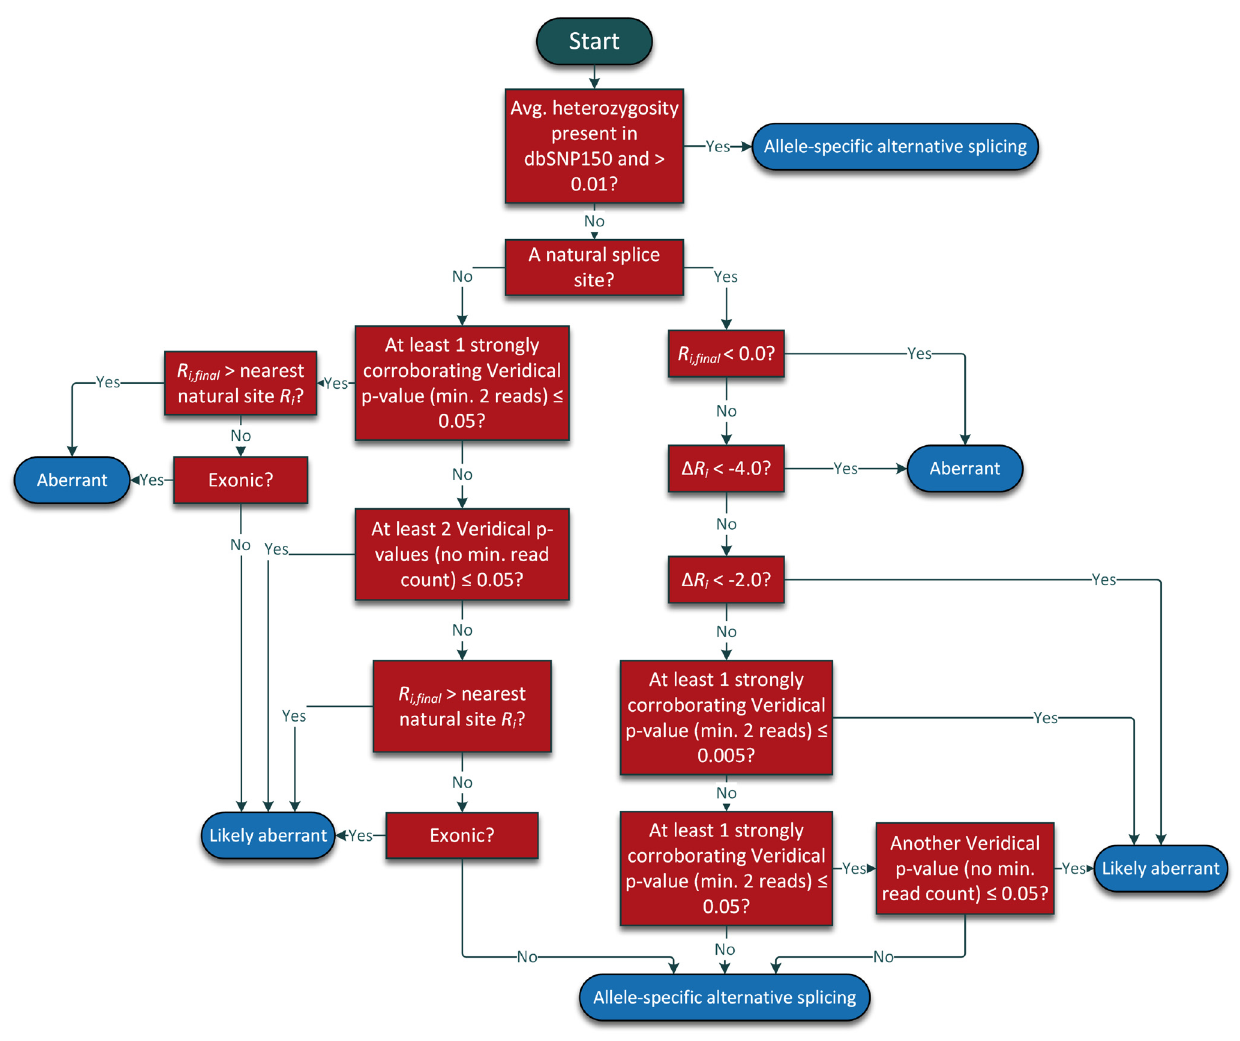
Figure 2. Evidence-Based Case Classification Flowchart. Flowchart depicting steps taken to classify the molecular phenotype of each case. Cryptic site (left) and natural site changes (right) have differing categorization criteria, which involve the combination of information theory-based predictions and Veridical evidence. SNPs common in dbSNP150 (>0.01 average heterozygosity) are immediately considered allele-specific alternative